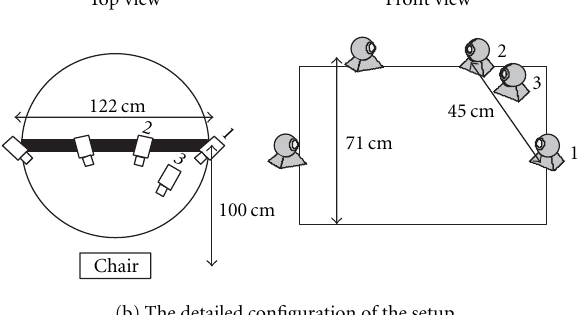
Figure 10: The real scenario of a data capturing process together with the detailed description of the setup configuration for exper- imenting the view reconstruction algorithm. The camera C 3 (3) is served as a virtual viewpoint to verify the final reconstruction